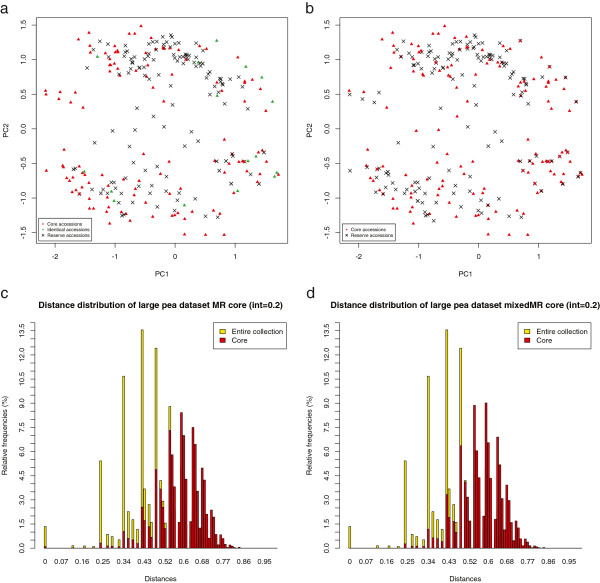
PCA plots and distance histograms of cores sampled from large pea dataset. This figure shows both PCA plots and distance histograms of core collections sampled from the large pea dataset, once obtained by optimizing mean MR alone and once by optimizing the mixed MR objective which includes both mean and minimum MR distance with equal weight. The sampling intensity was set to 0.2 and cores where constructed using the LR method. (a) optimizing mean Modified Rogers’ distance – core structure, (b) optimizing mixed Modified Rogers’ distance – core structure, (c) optimizing mean Modified Rogers’ distance – pairwise distance distribution, (d) optimizing mixed Modified Rogers’ distance – pairwise distance distribution.